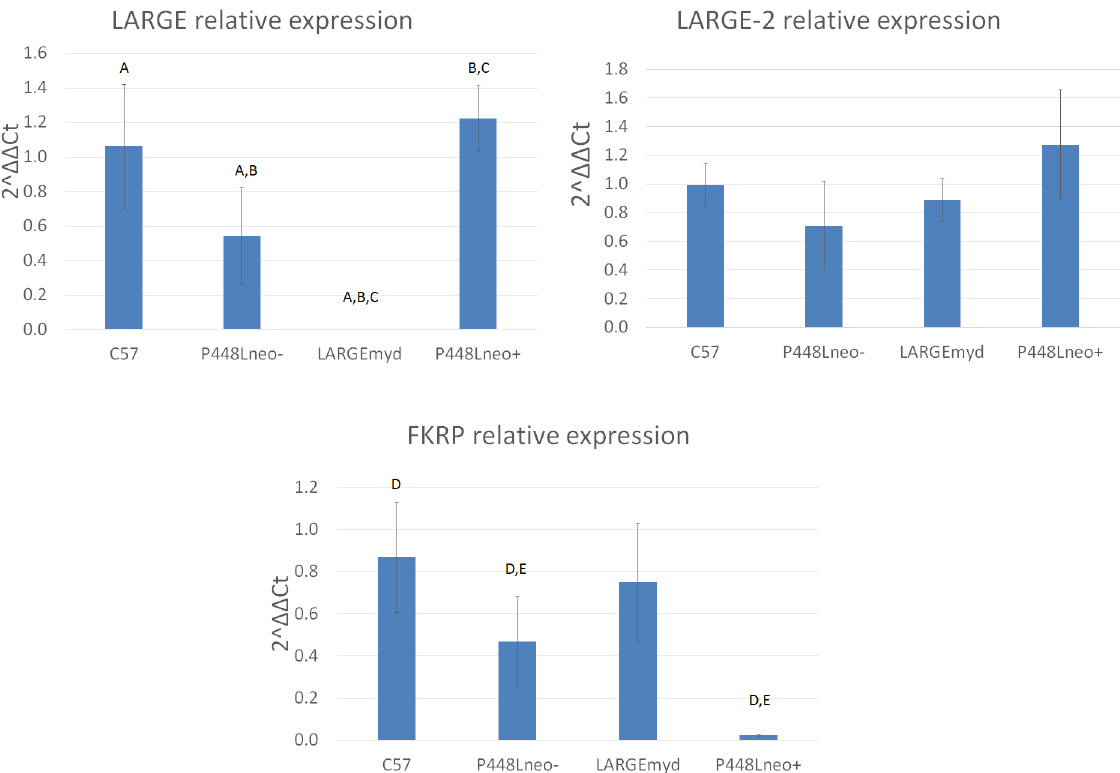
Fig 8. Quantitative real time-PCR of salivary gland. FKRP expression levels are normal in LARGE myd compared to C57 controls while significantly reduced levels are seen in the P448Lneo- and almost absent in the P448Lneo+. LARGE expression levels are high in the C57 as well as both P448Lneo- and neo+, although a decrease is noted in the P448Lneo-. However, as expected, LARGE expression levels are absent in the LARGE myd mouse. LARGE-2 expression shows near normal levels for all three mutant mouse models with no significant difference for any. Significant differences are noted with the same letter as determined by t-test with a p < 0.05.